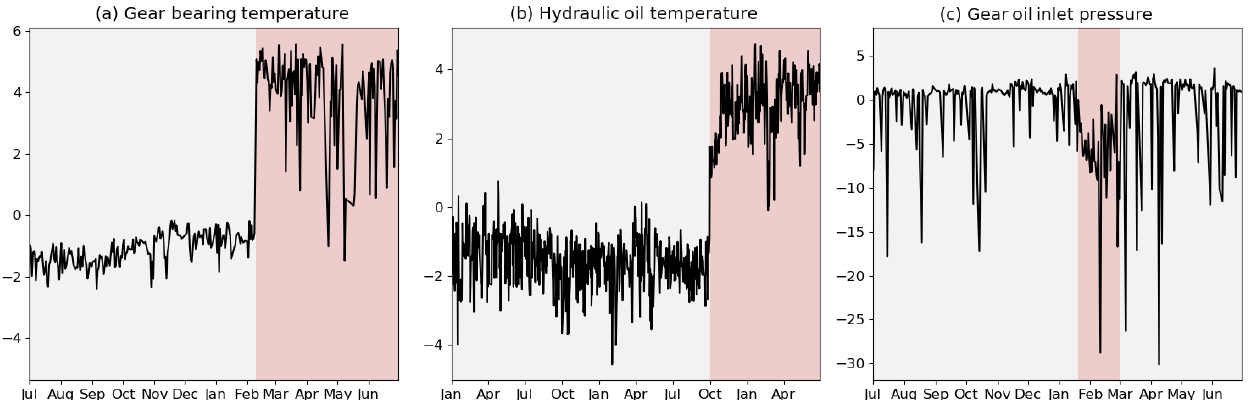
Figure 5. Exemplary SCADA signals after preprocessing (compare Fig. 3). Each change in background colour indicates a CP.